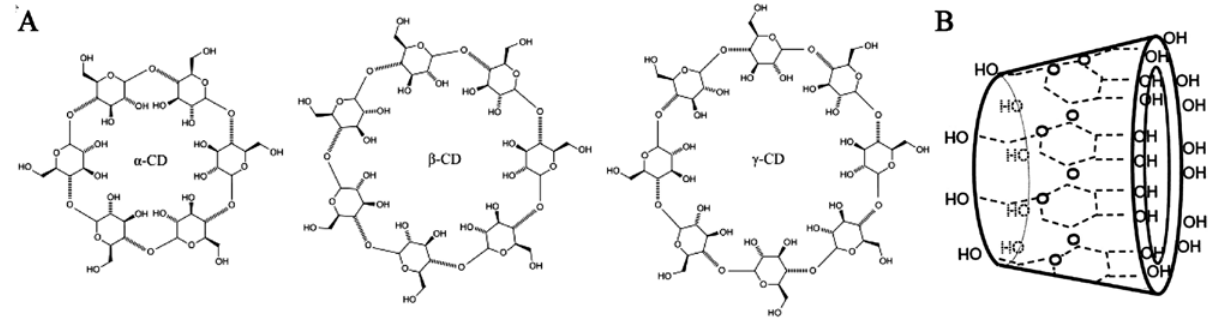
Figure 8: (A) Chemical structure of the three main types of cyclodextrins (B) γ -CD toroid structure showing spatial arrangement.